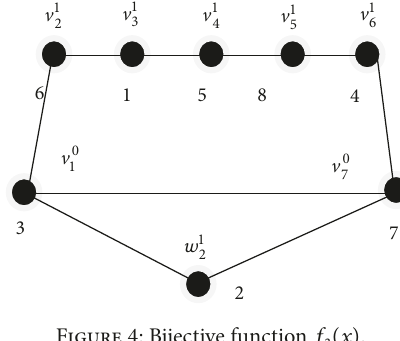
Figure 3: Bijective function 𝑓 2 (𝑥) .